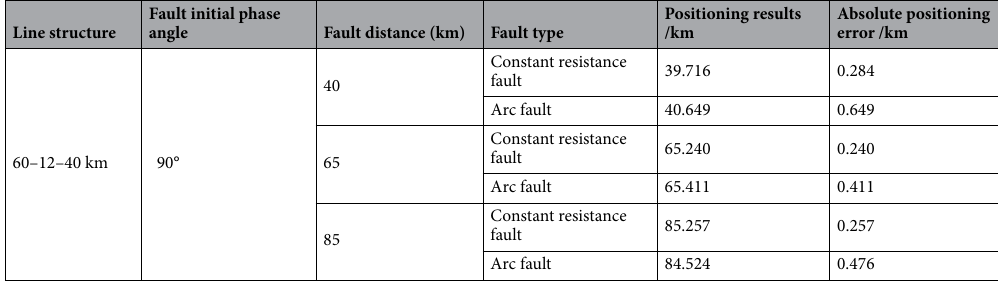
Table 9. Positioning results under constant resistance fault and arc